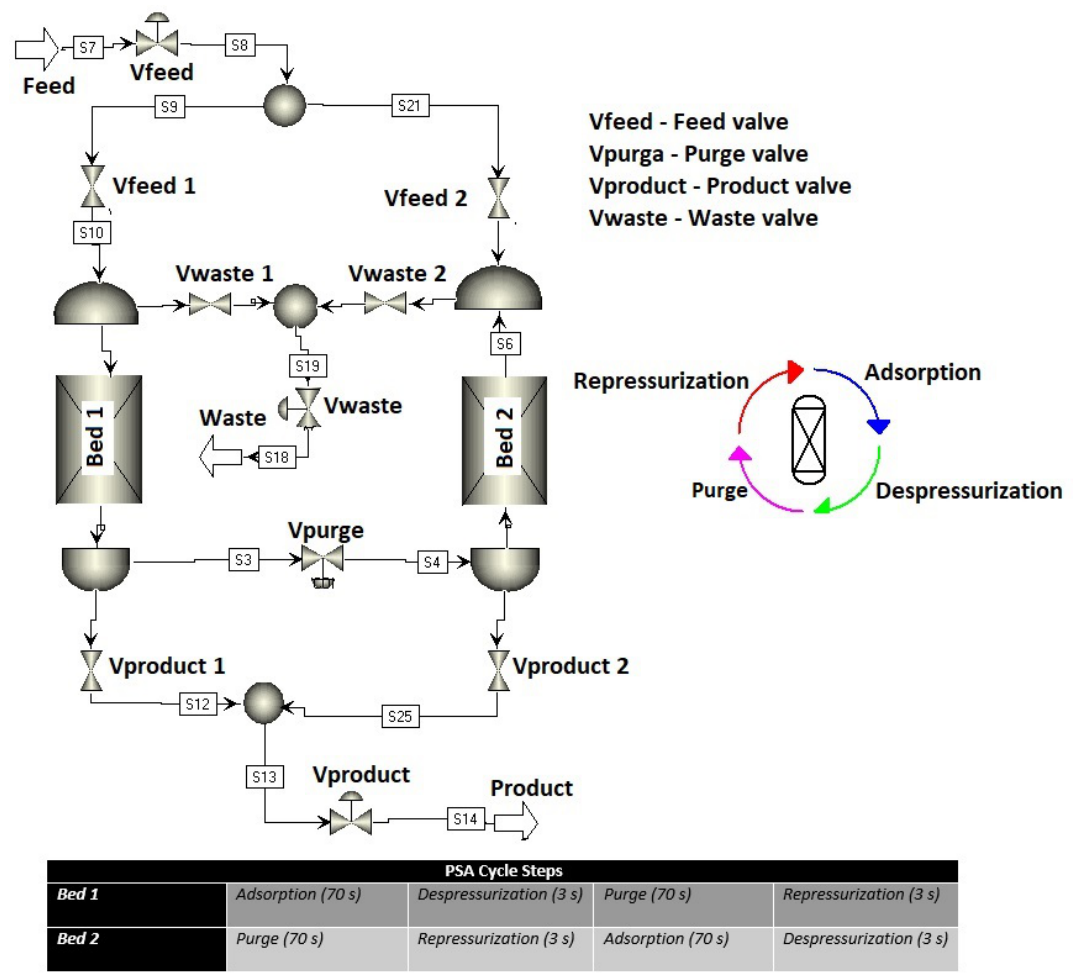
Figure 1. Scheme of the PSA process for the purification and production of